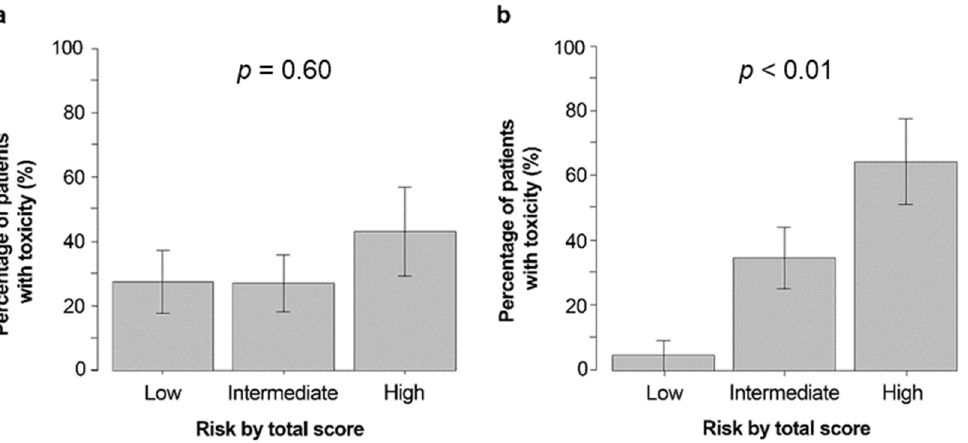
Figure 2. Percentage of participants with severe hematologic ( a ) and non-hematologic ( b ) toxicities based on CARG predictive tool risk strata. Abbreviations: CARG, Cancer and Aging Research Group.